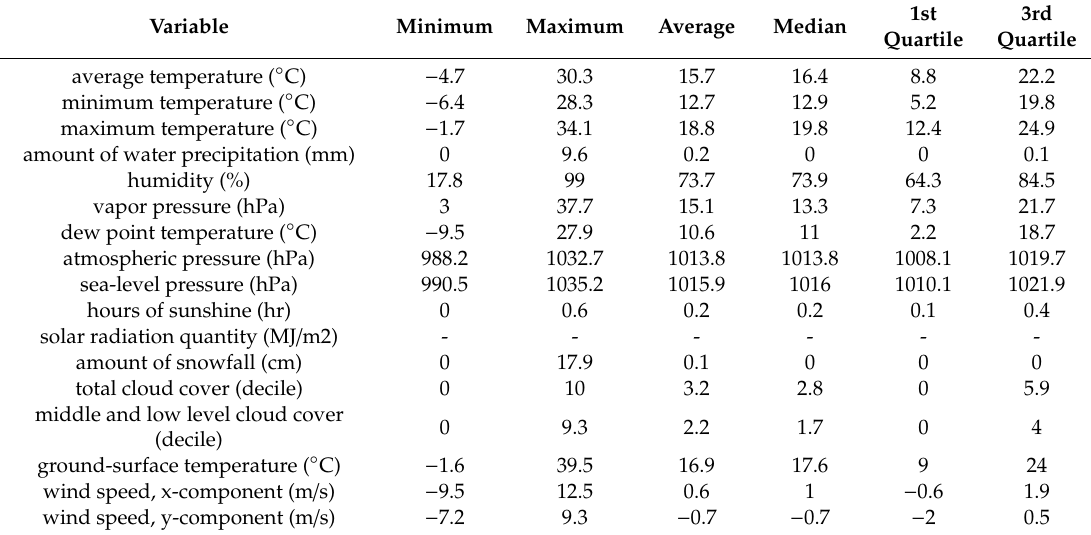
Table 13. Basic statistics for daily data in coastal area (Seongsan).